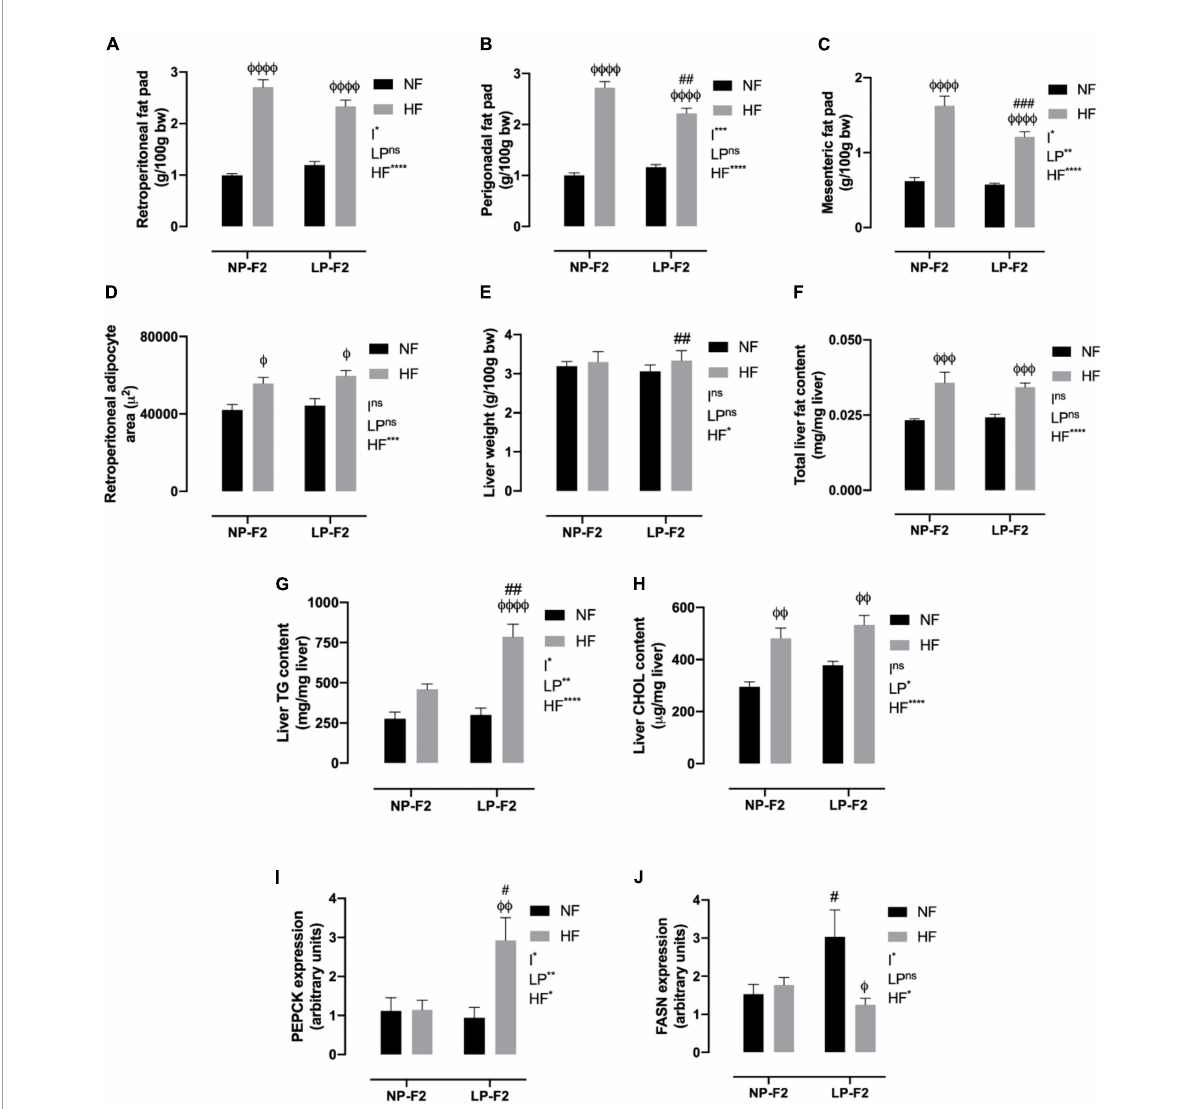
FIGURE5 Fat pad store and hepatic profile at 90 days old. Retroperitoneal (A) , perigonadal (B) , mesenteric fat pad store (C) , retroperitoneal adipocyte area (D) , liver weight (E) , total liver fat content (F) , liver triglycerides content (G) , liver cholesterol content (H) , PEPCK (I) and FASN expression (J) . The data are expressed as the mean ± S.E.M. and were obtained from 8 to 12 rats of each group (from 3 to 4 different litters). # p < 0.05, ## p < 0.01, ### p < 0.001, #### p < 0.0001 to NP-F2 vs. LP-F2 in the same conditions; ϕ p < 0.05, ϕϕ p < 0.01, ϕϕϕ p < 0.001, ϕϕϕϕ p < 0.0001 to NF vs. HF in the same group for the probability based on the Tukey’s post hoc analysis. LP, low-protein diet factor; HF, high-fat diet factor; and I, interaction between LP and HF factors. * p < 0.05, ** p < 0.01, *** p < 0.001, **** p < 0.0001, and ns, no significant difference, based on two-way analysis of